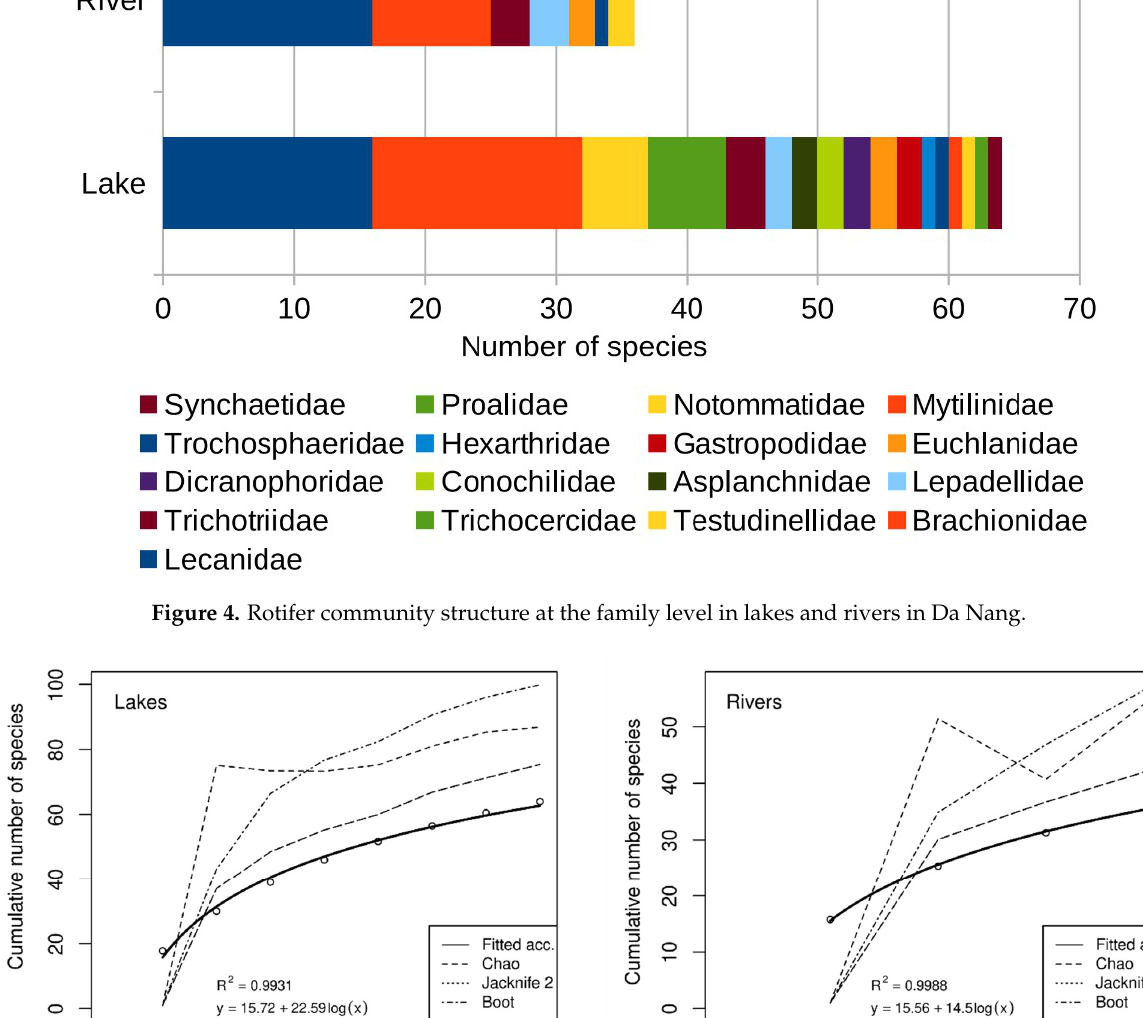
Figure 4. Rotifer community structure at the family level in lakes and rivers in Da Nang.